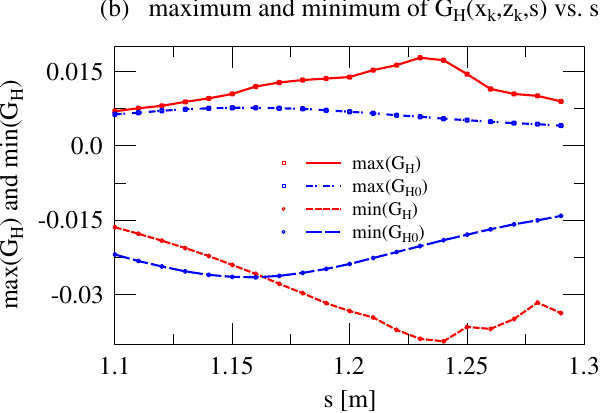
FIG. 10. (Color) Thick-bunch case: (cid:18) (cid:1) 10 (cid:4) 3 . (a) Mean of G (cid:12) H 0 representative particles; and (b) maximum and minimum values (cid:3) ~ x ; ~ z ; s (cid:5) and G of G H k k path length s